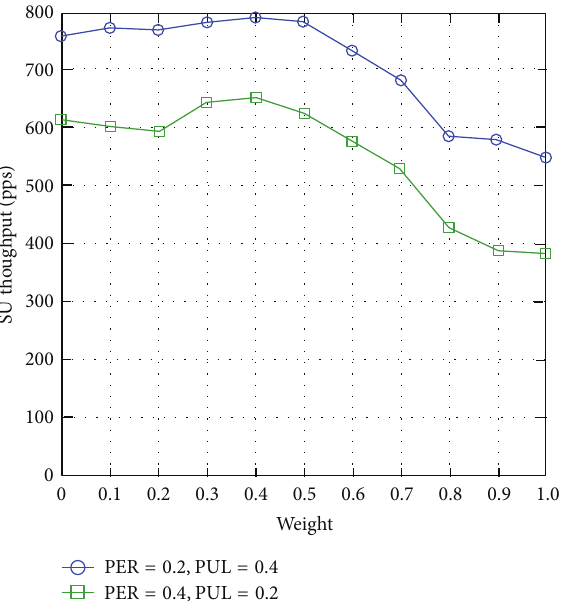
Figure 8: SU packet loss for varying weight factor 𝜔 . Figure 9: SU throughput for varying weight factor